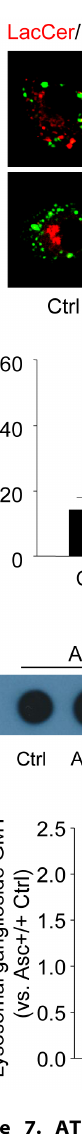
DOCK2, a guanine nucleotide exchange factor that mediates